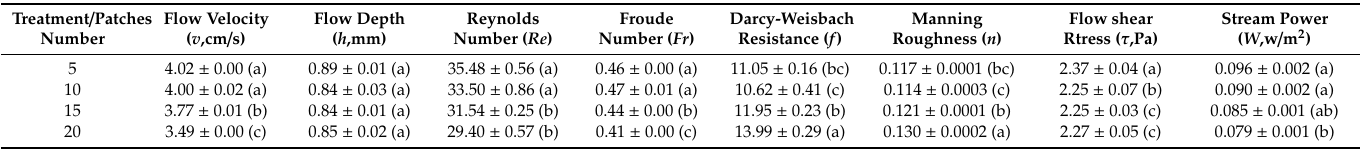
Table 6. Flow hydrodynamic parameters for the di ff erent numbers of vegetation patches under simulated